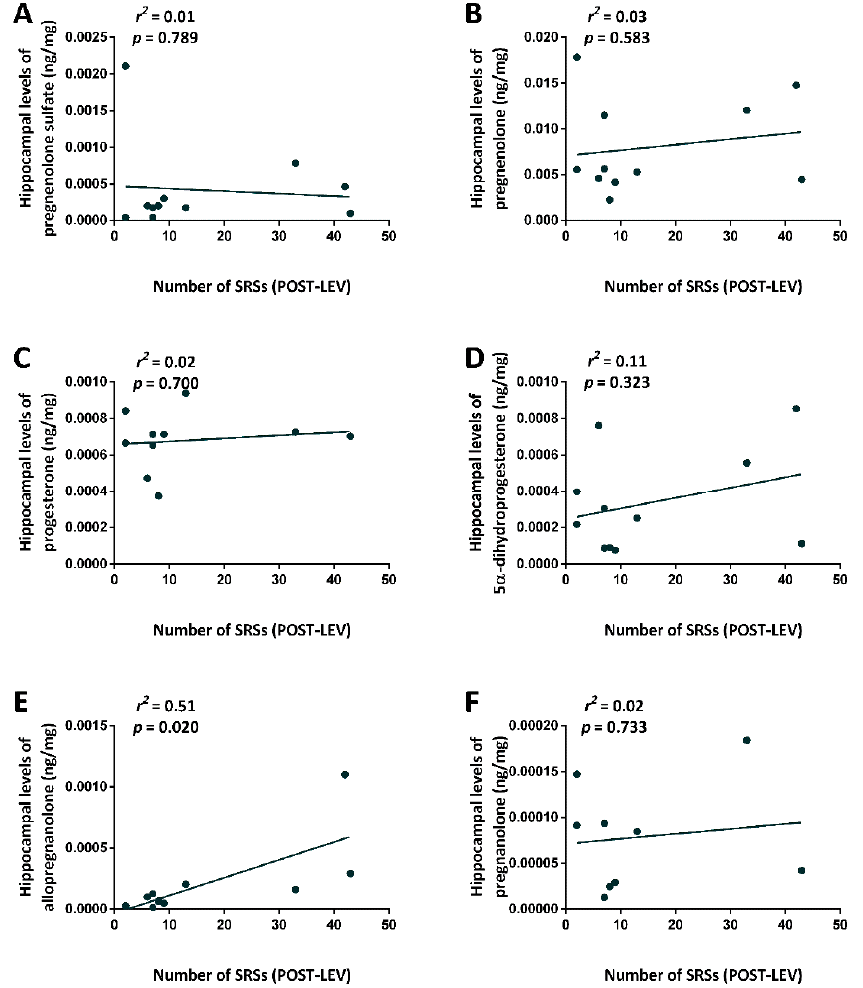
Figure 6. Relationship ( r 2 ) between the number of spontaneous recurrent seizures (SRSs) after treatment with levetiracetam (LEV, 8 weeks after treatment with KA) and the hippocampal neurosteroid levels measured in LEV-treated rats, 2 weeks after treatment. Statistical analysis was performed using a linear regression analysis, with neurosteroid levels as dependent variable and the number of SRSs as independent variable ( A – F ). POST-, after minipump implantation.